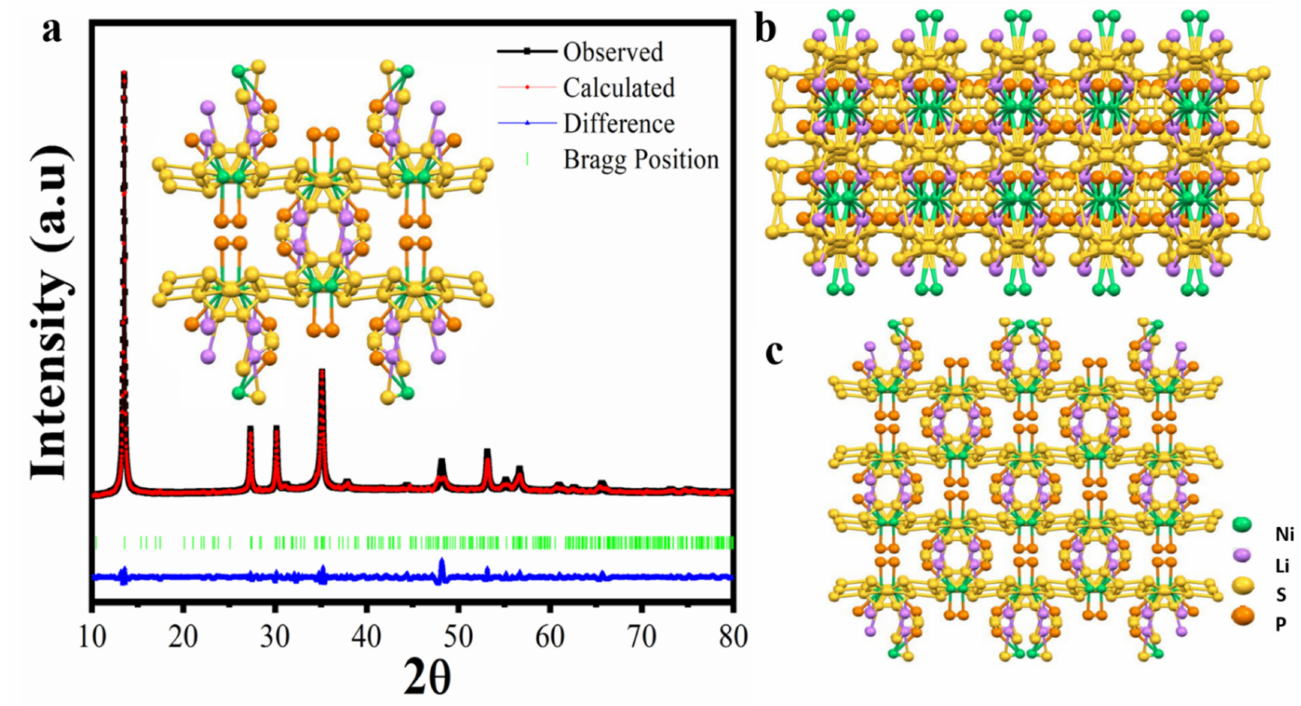
Figure 1. Experimental and simulated Rietveld refinement analysis and crystal structure of NLPS: ( a ) Rietveld analysis of X-ray powder diffraction data of NiLiP 2 S 6 and unit cell; ( b ) complete crystal structure; ( c ) asymmetrical 2 × 2 layer crystal